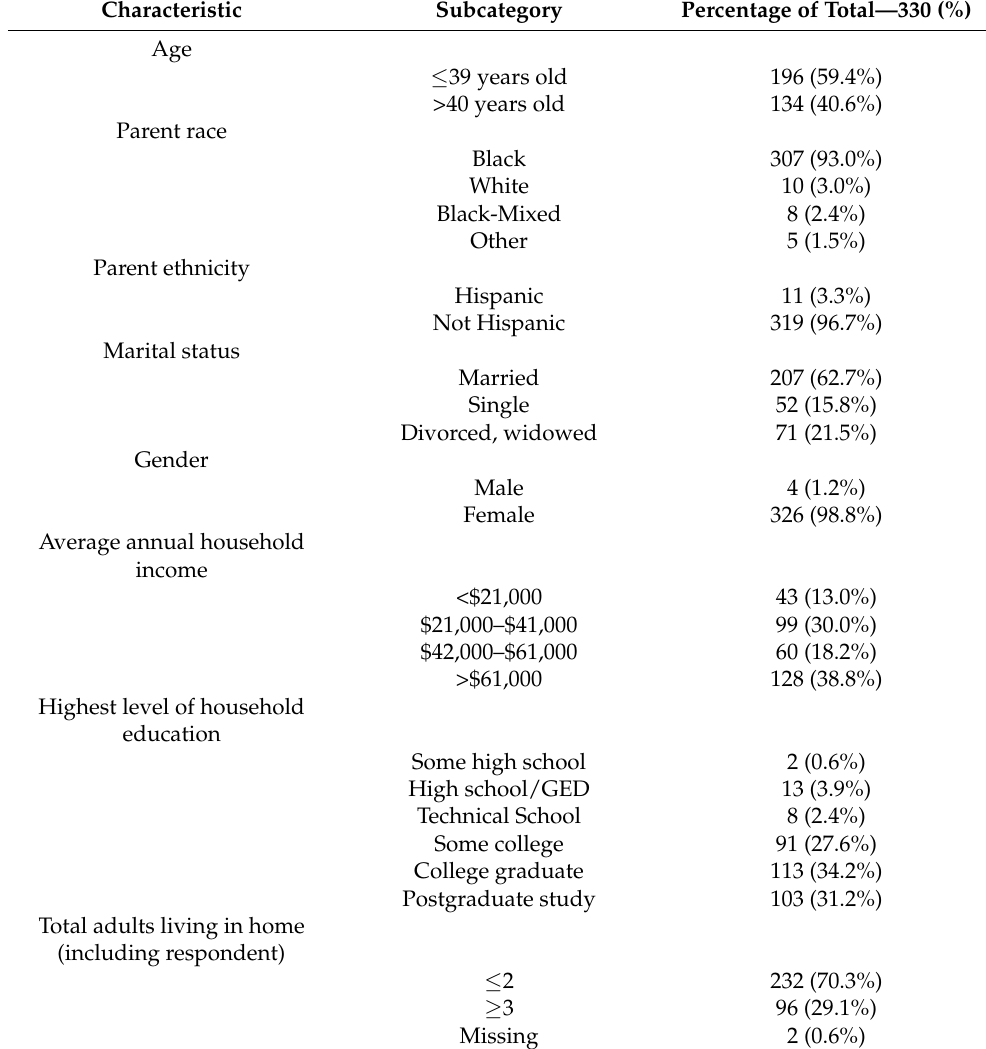
Table 1. Parent Demographics and the Home Environment (n =